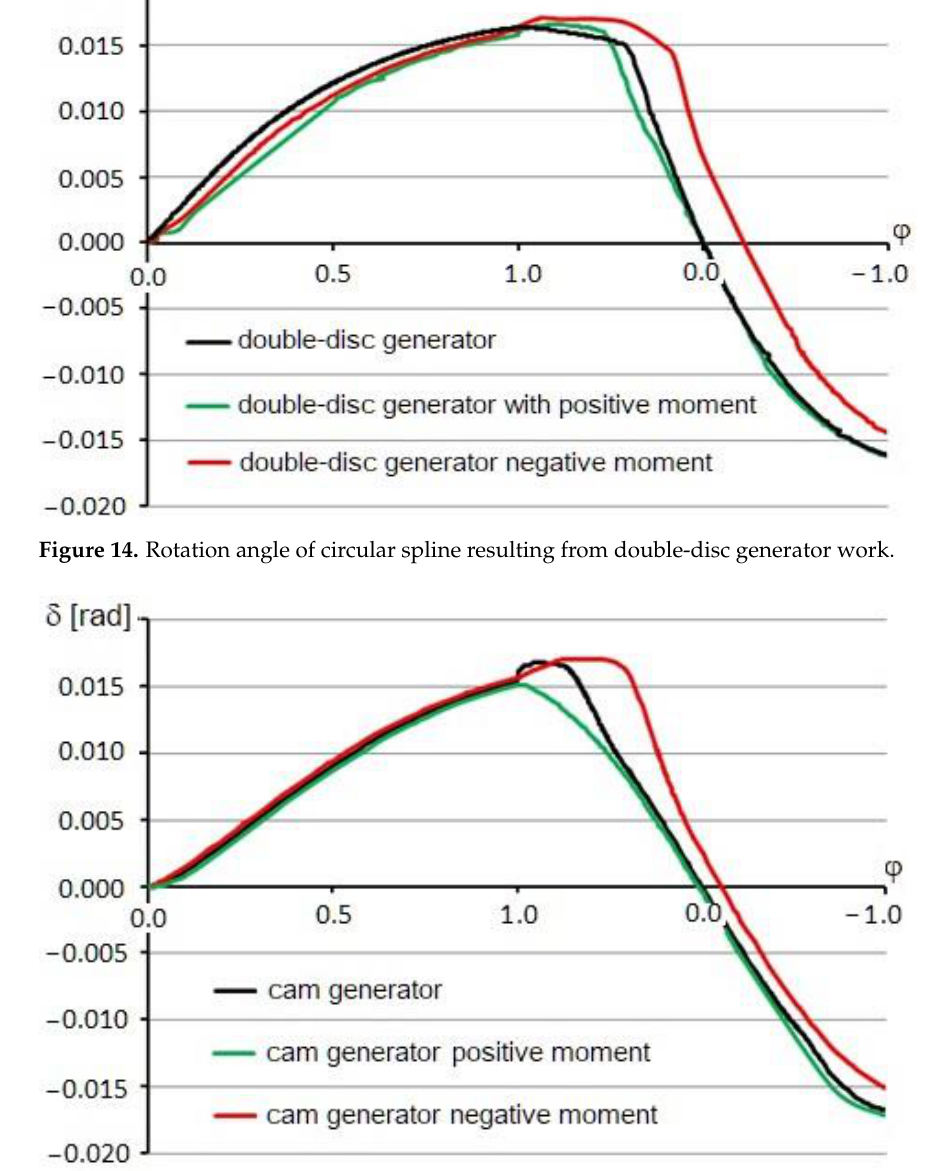
Figure 15. The rotation angle of the circular spline resulting from the cam generator work.